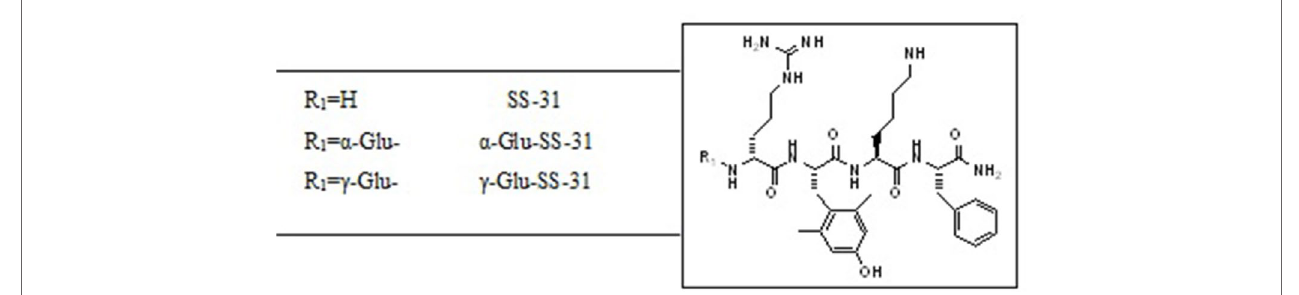
FIGURE 6 | Chemical structures of SS-31 and the evaluated functionalized analogs. The prodrugs are composed of the active compound (SS-31) and the targeting α -Glu or γ -Glu-moiety as substrates for the enzymes aminopeptidase A (APA) and γ -Glu-transpeptidase ( γ -GT), respectively.